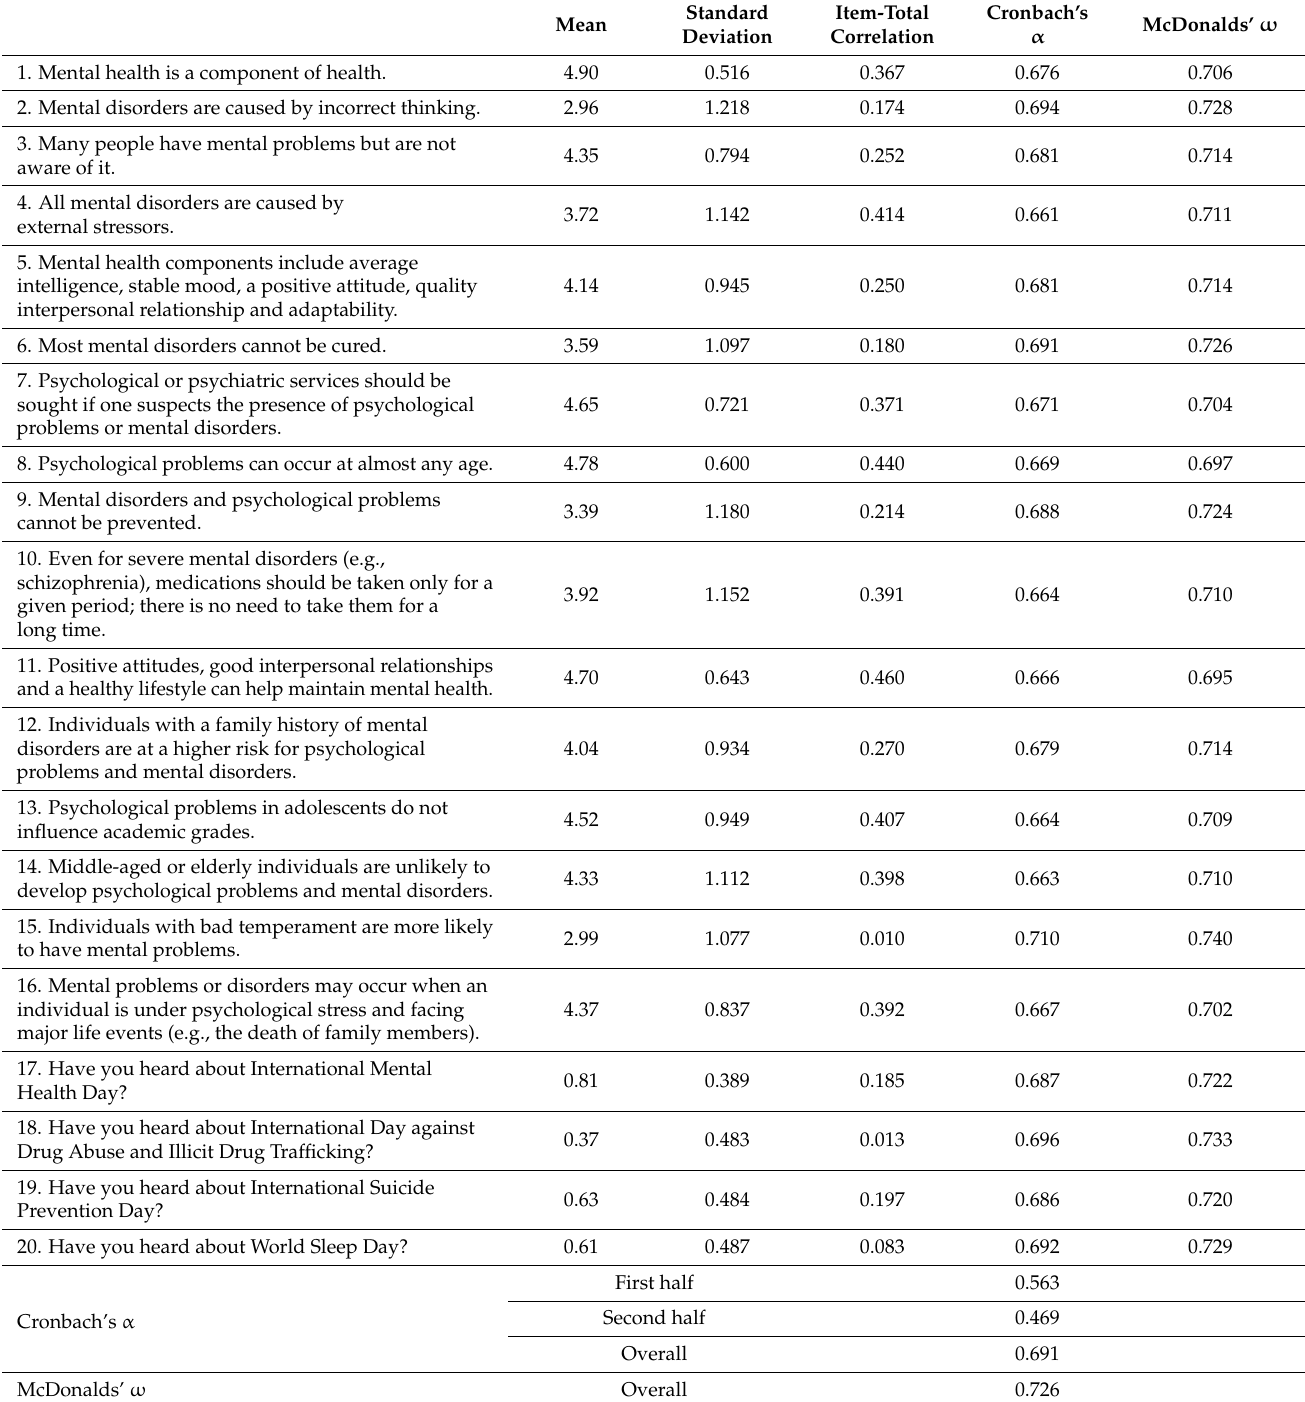
Table 1. Statistics (mean and standard deviation), item-total correlation, Cronbach’s alpha, and McDonalds’ omega coefficients of the Mental Health Knowledge